Question: Which visualization type does this figure use?
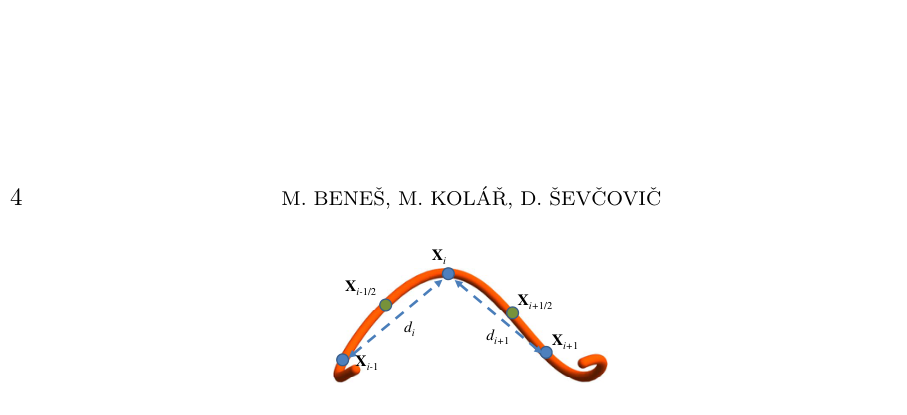
Answer: line